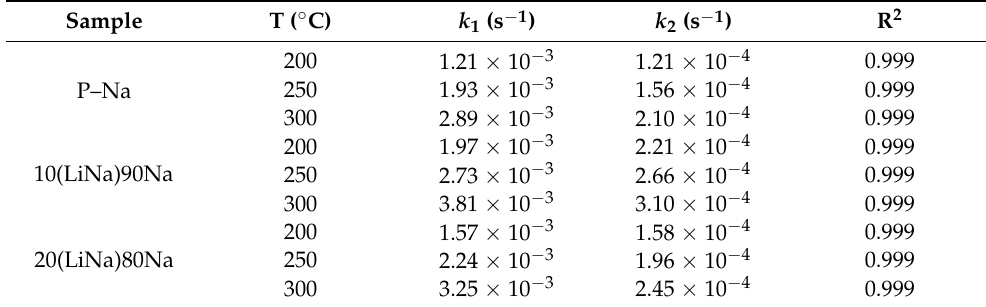
Table 1. Kinetic parameters of P–Na, 10(LiNa)90Na, and 20(LiNa)80Na at 200–300 ◦ C.